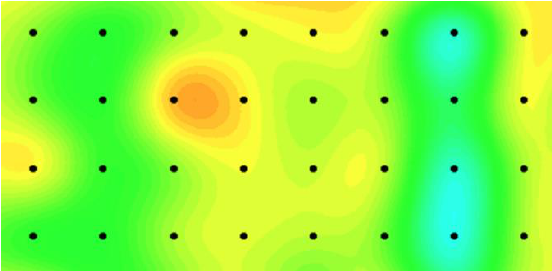
Figure 7. illustration of a grain temperature plan during grain storage. Figure 7. Illustration of a grain temperature plan during grain